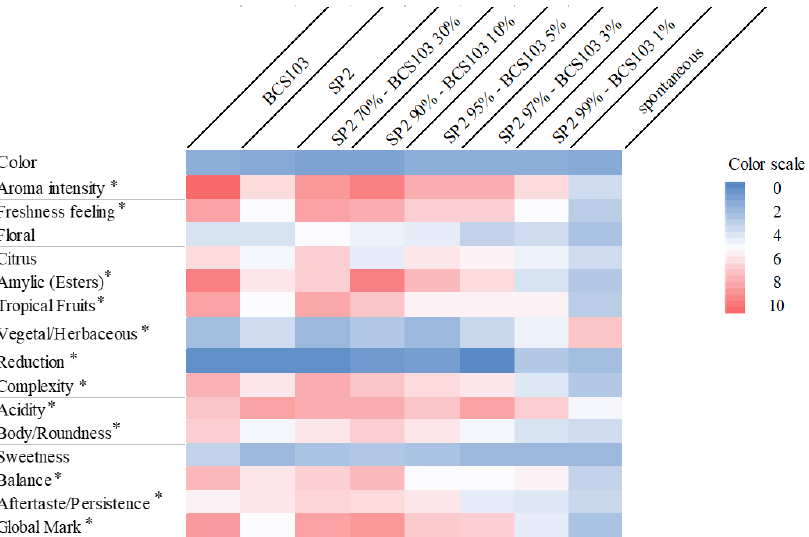
Figure 4. Heatmap analysis representation corresponding to Sauvignon Blanc wine sensory evaluation fermented under different inoculation schemes. The relative content of each sensory attribute is illustrated through a color scale (from dark blue, minimum, to dark red, maximum). The asterisk denotes a statistically significant difference ( p < 0.05) between each attribute and the fermentation schemes.